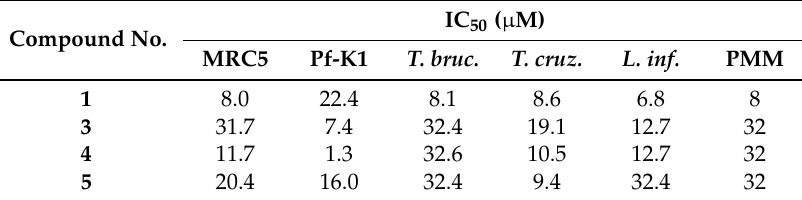
Table 2. Antiprotozoal and cytotoxic activities of isolated compounds from Ferula narthex (IC 50 , µ M).